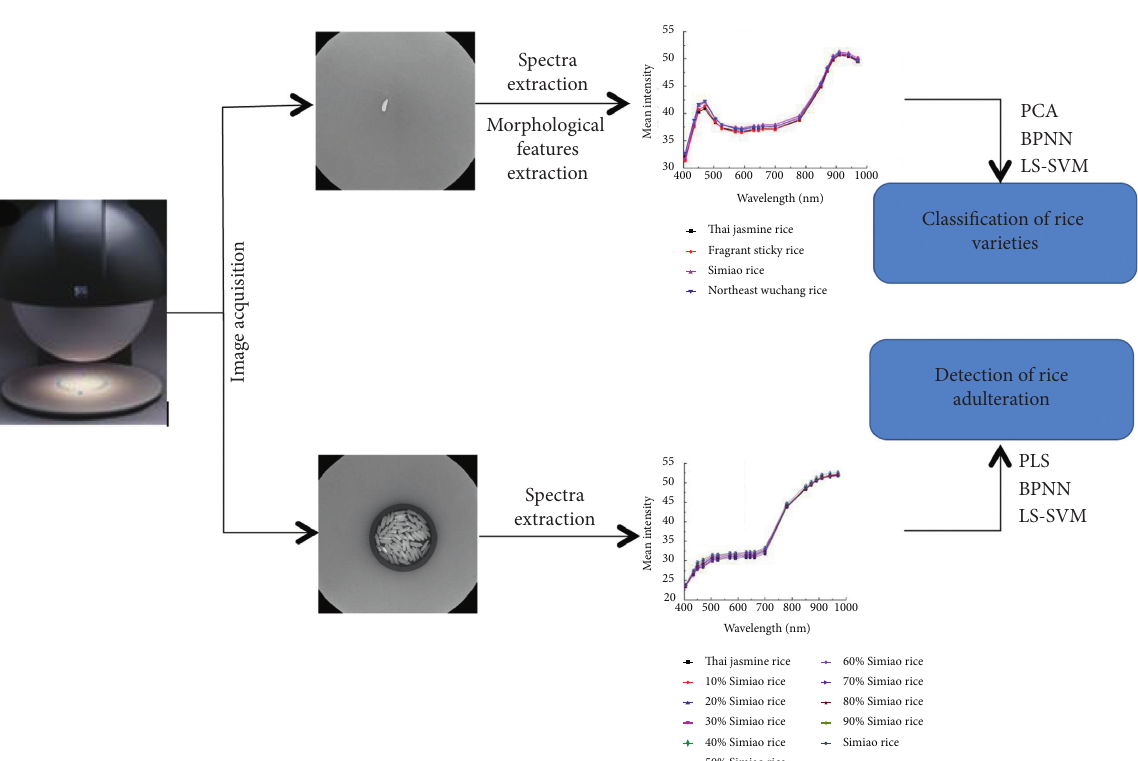
Figure 2: Flowchart of main steps for authenticity detection of Thai jasmine rice using multispectral imaging.